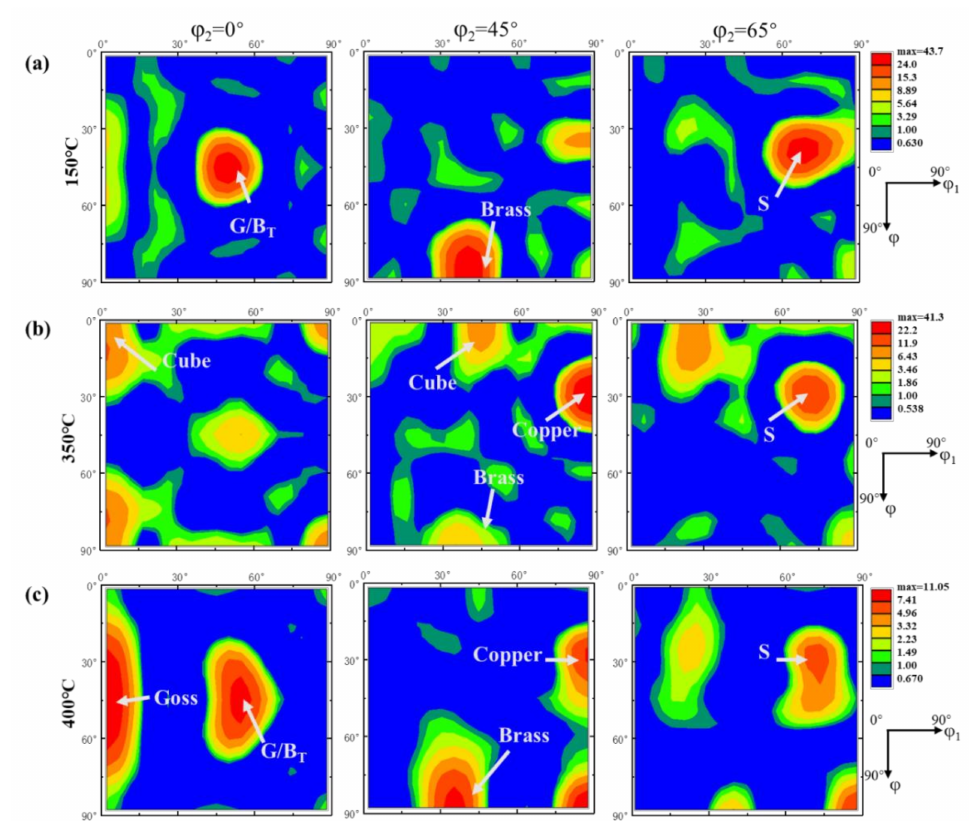
Figure 4. The ϕ 2 =0 ◦ , 45 ◦ and 65 ◦ ODF sections of the samples after annealing at ( a ) 150 ◦ C, ( b ) 350 ◦ C and ( c ) 400 ◦ C before thermal